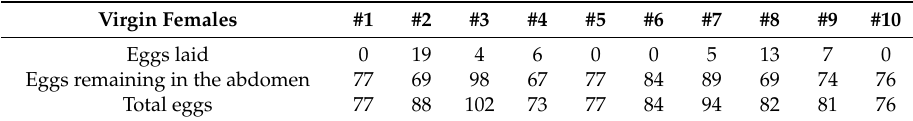
Table 1. Egg production capacity of ten virgin Xylotrechus chinensis